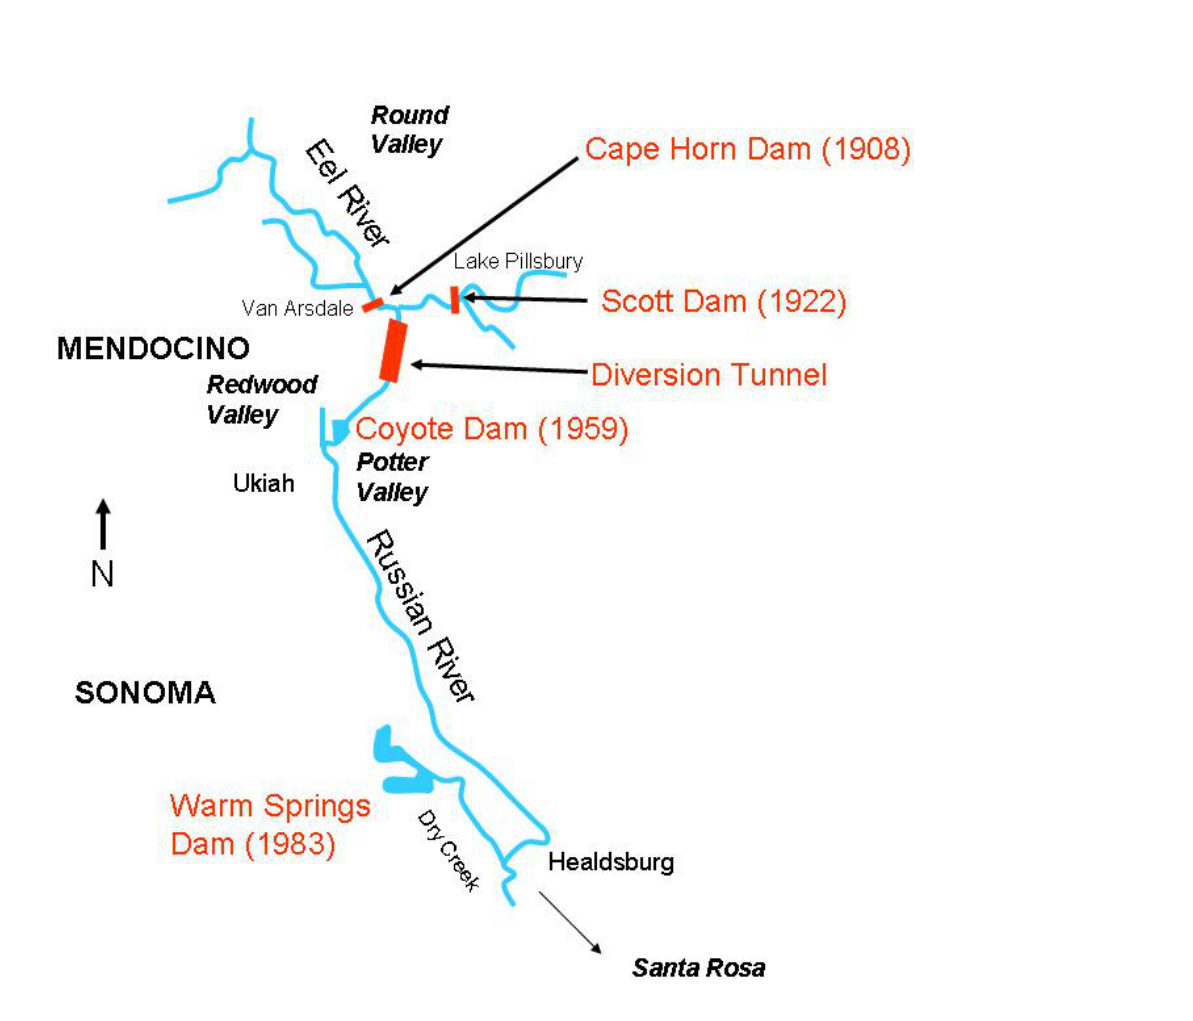
Fig. 2. The Potter Valley